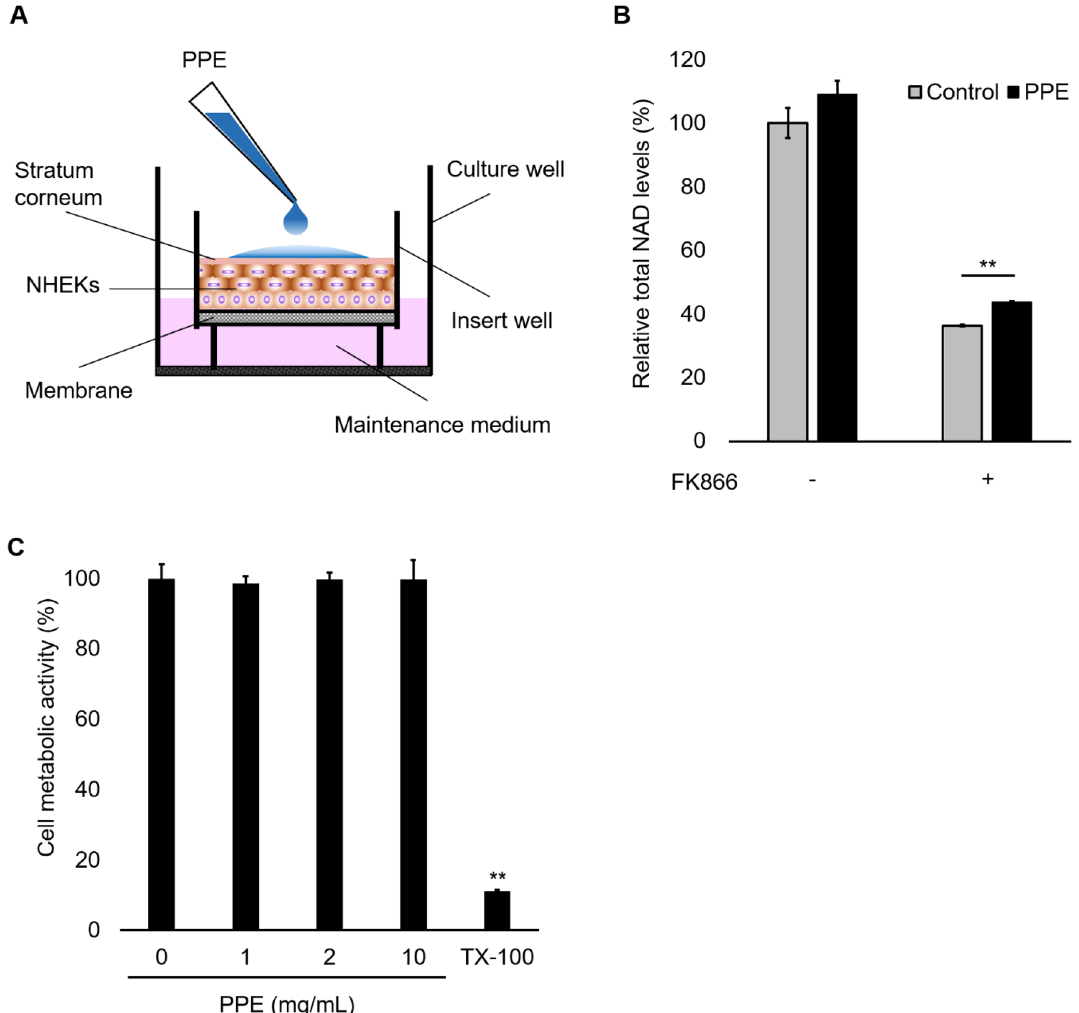
Figure 4. Topical PPE shows NAD recovery activity, but does not affect cell metabolic activity, in RHE. ( A ) Schematic illustration of the RHE model. ( B ) PPE (2 mg/mL) was applied to the stratum corneum side of RHE and incubated for 48 h in the presence or absence of FK866 (5 nM). The total NAD levels of tissues were determined using NAD + /NADH assay kit. ( C ) PPE (0, 1, 2, or 10 mg/mL) or 1% TX-100 (as the positive control) was applied to the stratum corneum side of RHE and incubated for 48 h. The cell metabolic activity was determined by MTT assay. ** p < 0.01, the comparison to the